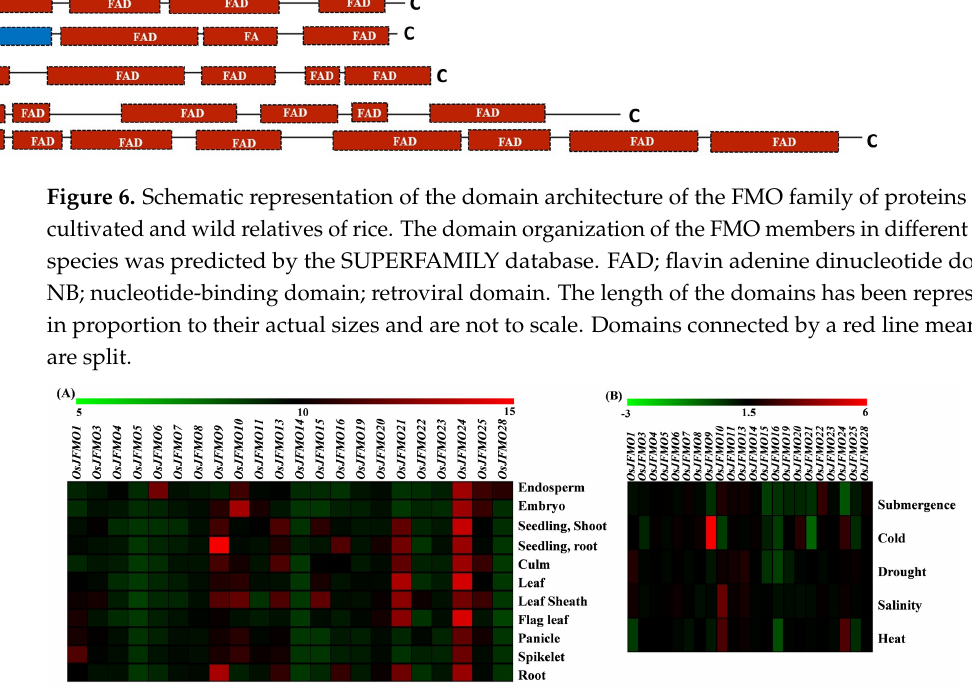
Figure 7. Spatial and stress-mediated expression profiling of different FMO genes cultivated variety O. sativa subsp. japonica . Expression data were retrieved from the publicly available Affymetrix as well as RNA-seq datasets from the Genevestigator for ( A ) different tissues during development and ( B ) under different abiotic stress conditions namely heat, salinity, cold, drought and submergence. All expression values with p value < 0.05 have been depicted in log 2 fold change. The heatmaps have been generated using MeV software. The color scale below each heatmap shows the level of expression, with red color showing the highest expression and green showing the lowest